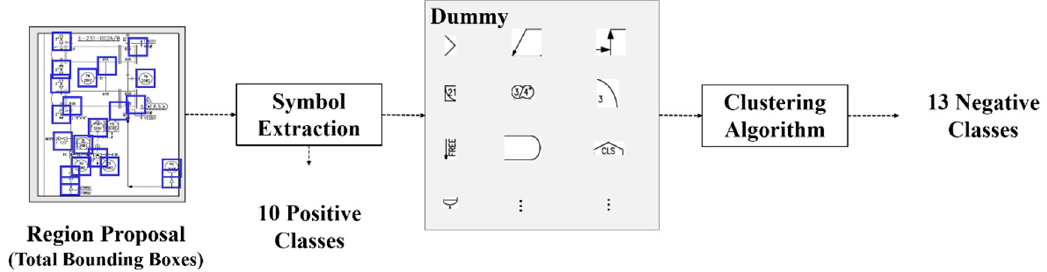
Figure 4. Data annotation: positive/negative samples.